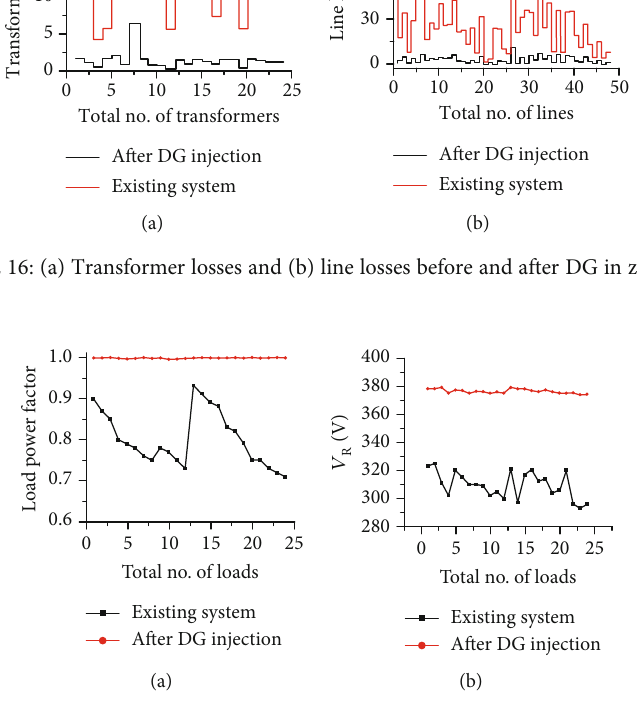
Figure 17: (a) Power factor and (b) voltage at the receiving end in zone A.